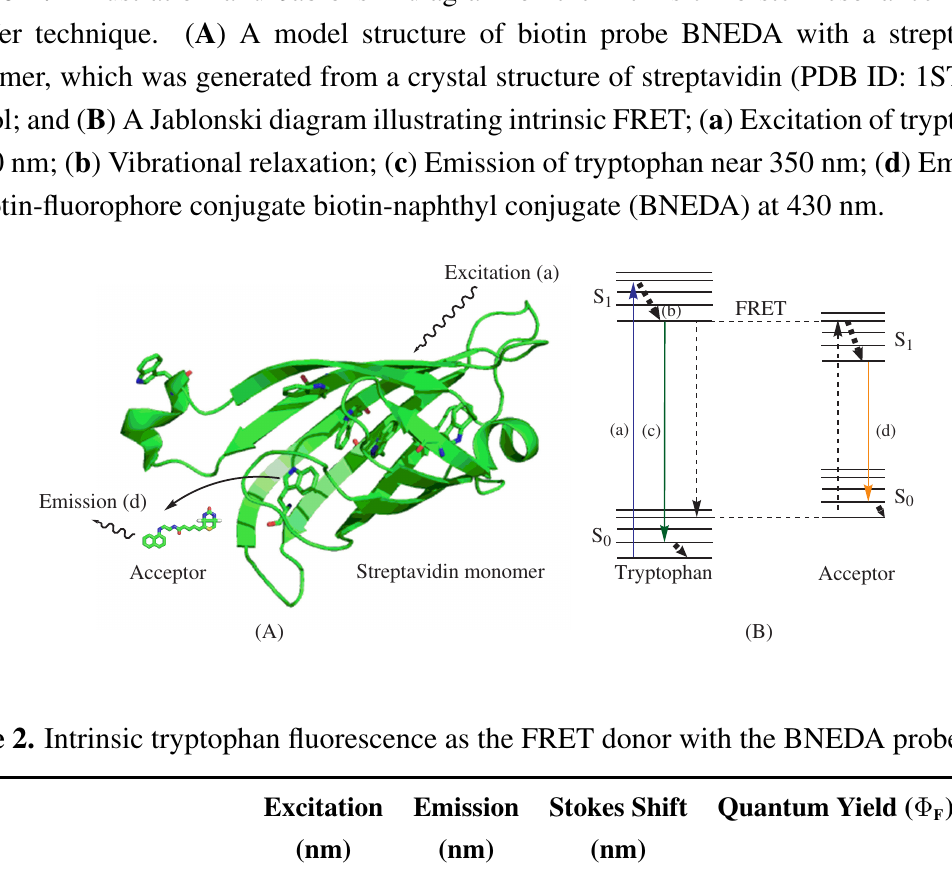
Figure 2. Illustration and Jablonski diagram of the intrinsic Förster resonance energy transfer technique. ( A ) A model structure of biotin probe BNEDA with a streptavidin monomer, which was generated from a crystal structure of streptavidin (PDB ID: 1STP) by PyMol; and ( B ) A Jablonski diagram illustrating intrinsic FRET; ( a ) Excitation of tryptophan